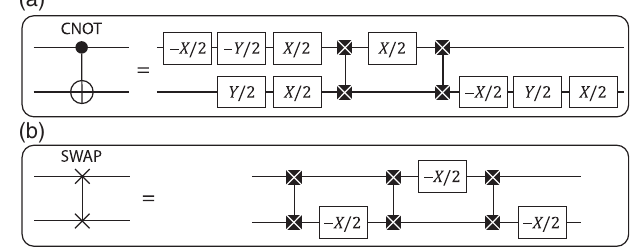
FIG. 26. (a) Decomposition of the CNOT gate into the iSWAP gates. (b) Decomposition of the SWAP gate into the iSWAP gates.